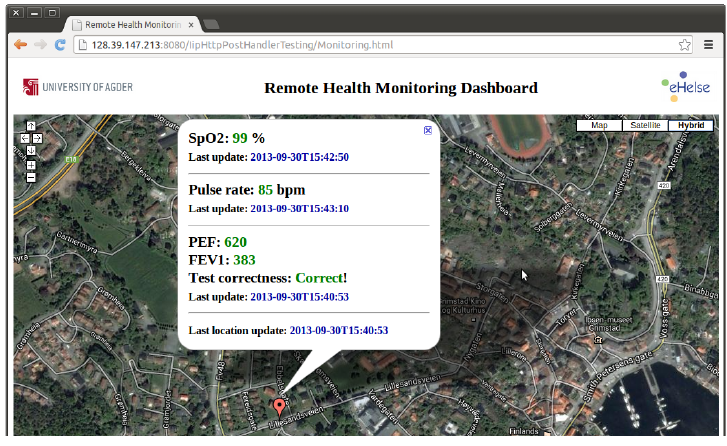
Figure 11. Remote health monitoring service user